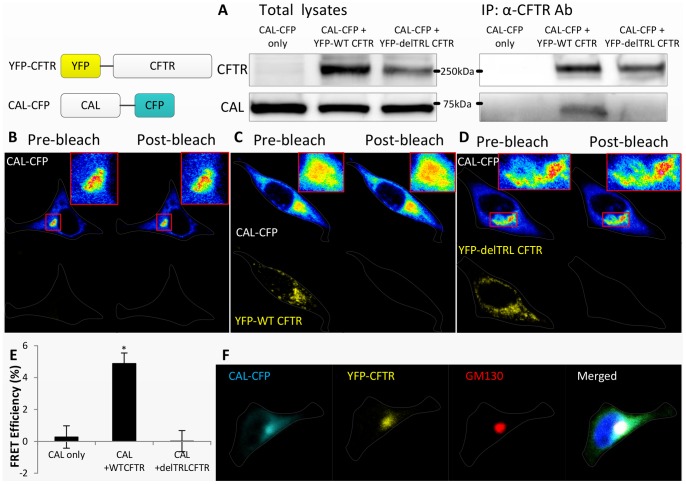
CAL-CFP binds YFP-CFTR in vivo, and CAL and CFTR are colocalized in the Golgi in HeLa cells.The N terminus of CFTR was tagged with YFP, and CFP was tagged to the C terminus of CAL was tagged with CFP. In HeLa cells, CAL-CFP was transiently expressed alone (A,B), with YFP-wildtype CFTR (A,C), or with YFP-delTRL CFTR (A,D). (A) Left panel: CAL-CFP, YFP-wildtype CFTR, and YFP-delTRL CFTR from total lysates were immunoblotted with anti-GFP antibody. Right panel: The cell lysates were immunoprecipitated with anti-CFTR antibody. (B-D) The left columns are the images before photobleaching with a 514-nm laser, and the right columns are the images after photobleaching. CFP and YFP are pseudocolored with a 16-bit lookup table (provided with ImageJ) and yellow, respectively. E shows the statistical analysis of the FRET efficiency obtained from the images. Results are means ±SE. (n = 11–13) *p<0.001. (F) YFP-CFTR and CAL-CFP were colocalized with GM130. HeLa cells that had been transfected with YFP-CFTR and CAL-CFP were immunostained with anti-GM130 antibody. The right-most panel shows the merged image of CAL-CFP, YFP-CFTR, GM130, and DAPI. (B–D, F). Cell outlines are drawn with gray lines.